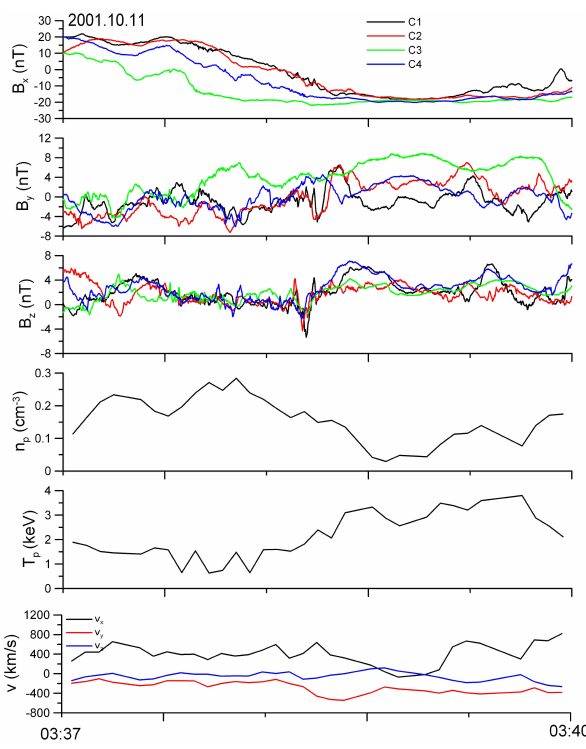
Fig. 4. Magnetic field components, proton density, temperature, velocity for the case 11 October 2001 (#5). Standard Cluster colors are